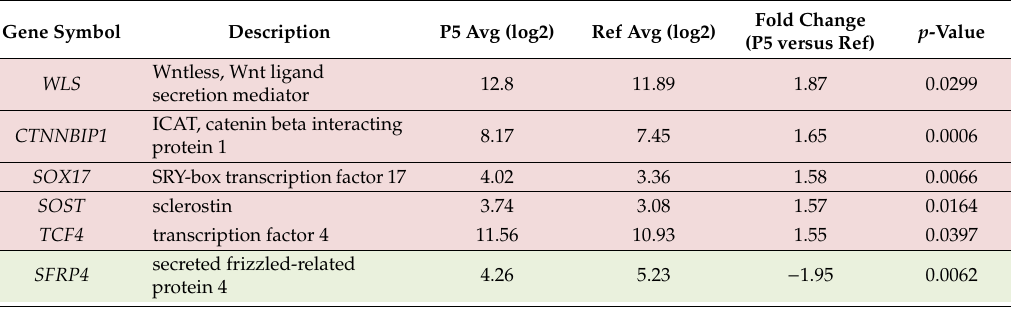
Table 1. Overview of significantly expressed genes related to Wnt / β -catenin pathway in MG-63s on micro-pillars (P5) compared with unstructured reference (Ref) (positive z-score value means a gene expression increase in MG-63s on P5 (red) and a negative z-score value means a lower gene expression on P5 versus Ref (green); microarray technology,